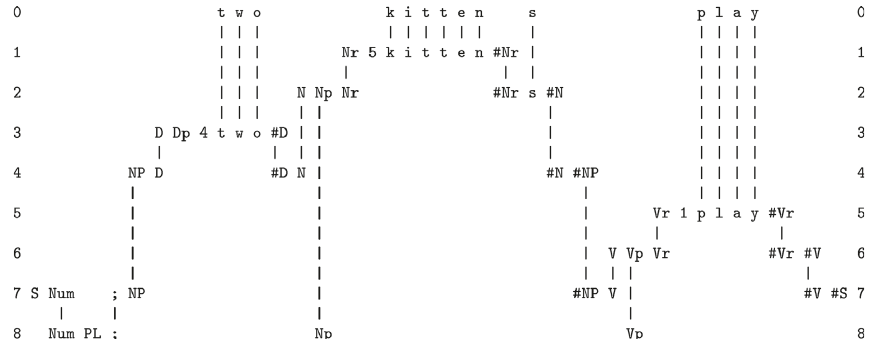
Figure 3: The best SP-multiple-alignment created by the SP Computer Model with a store of Old SP-patterns like those in rows 1 to 8 (representing grammatical structures, including words) and a New SP-pattern, “t w o k i t t e n s p l a y,” shown in row 0 (representing a sentence to be parsed) (adapted from Figure 1 in [25], with